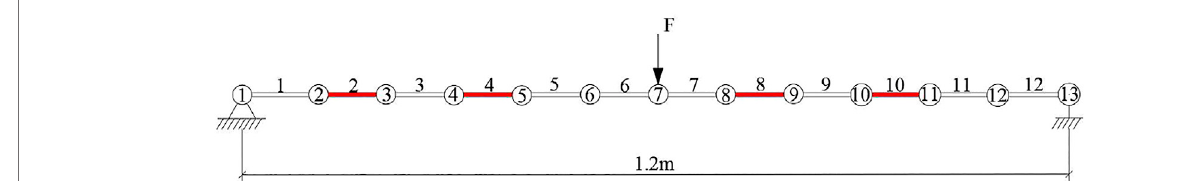
FIGURE 2 | Sketch of simply supported beam.